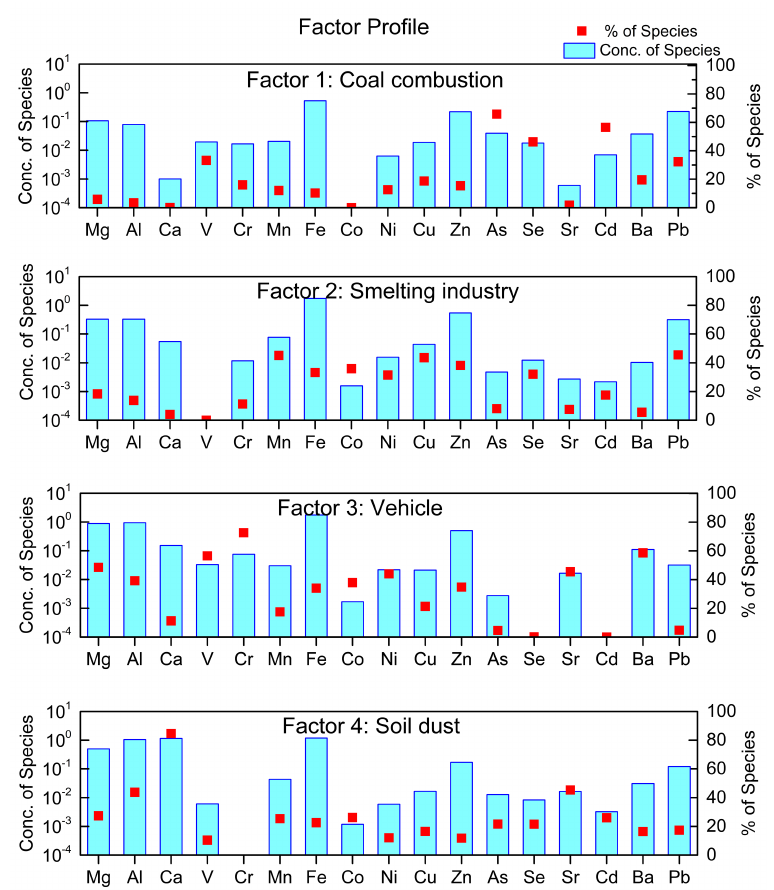
Figure 3. Four dominant factors contributing to PM 2.5 -bound elements using positive matrix factorization